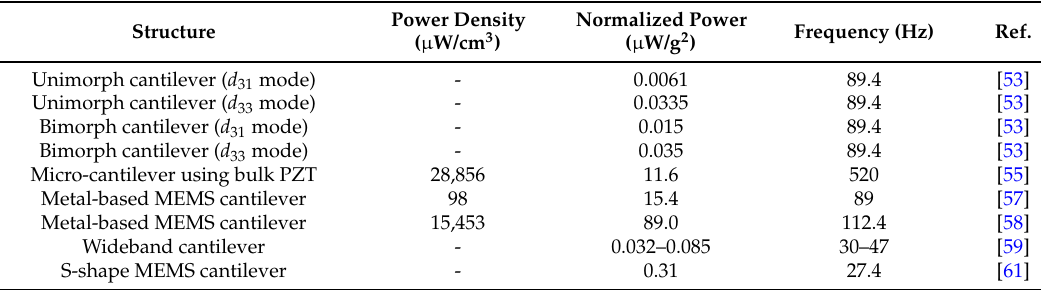
Table 2. Comparison of the output performance of the microelectromechanical systems (MEMS) piezoelectric vibration energy